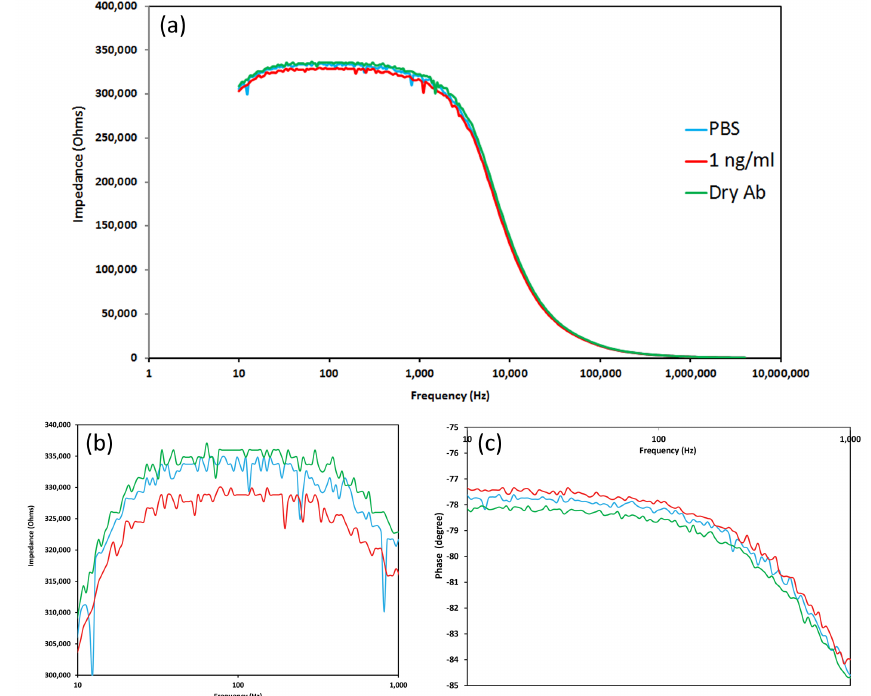
Figure 5. ( a ) Impedance spectroscopy (10–4 M Hz) of 1% ZnO:CuO (1:2) of 200 ng dry antibody, adding PBS and 1 ng/mL CRP for 10 min ( b ) magnified impedance spectroscopy (10–1000 Hz) and ( c ) phase plot (10–1000